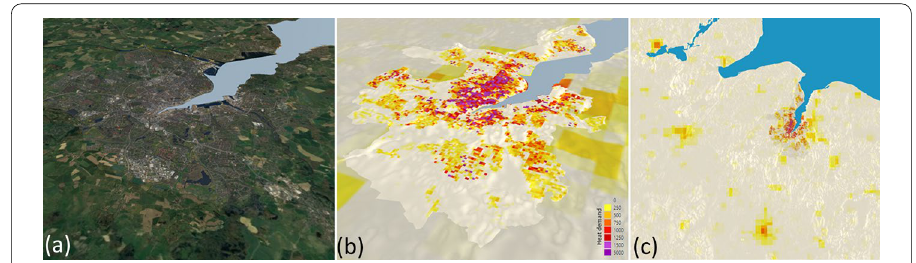
Fig. 4 Use of textures for conveying information. a For immersion, aerial imagery can be shown mapped onto the surface. Here, the city of Kiel is depicted with a texture at a much higher resolution than the surrounding region. b Additional information, such as heat demand density of building stock (in MWh /( ha × a ) ), can be easily conveyed using textures as well. c Again, a higher resolution texture has been applied for the city of Kiel, showing heat demand density at a 1 ha resolution while the general texture for the state has a resolution of 1 km